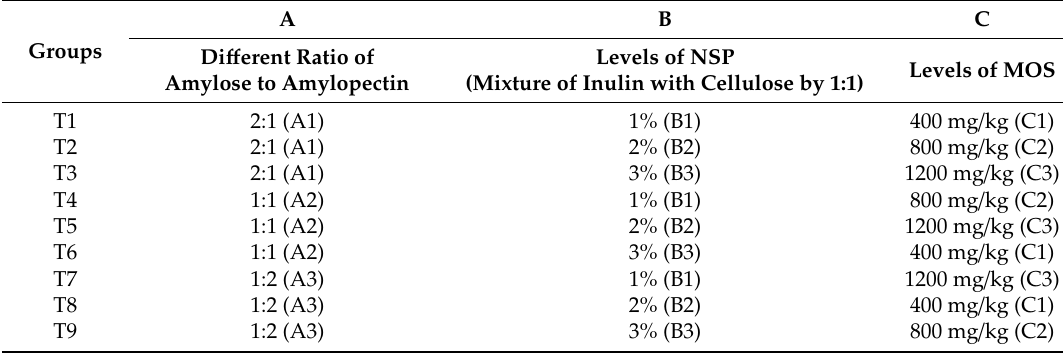
Table 1. L 9 (3 4 ) orthogonal array experimental parameter assignment.